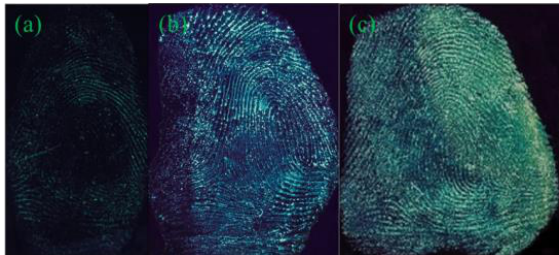
Figure 5. Fingermarks developed by G-CDs under various developing times. ( a ) 5 min; ( b ) 15 min; ( c ) 30 min.